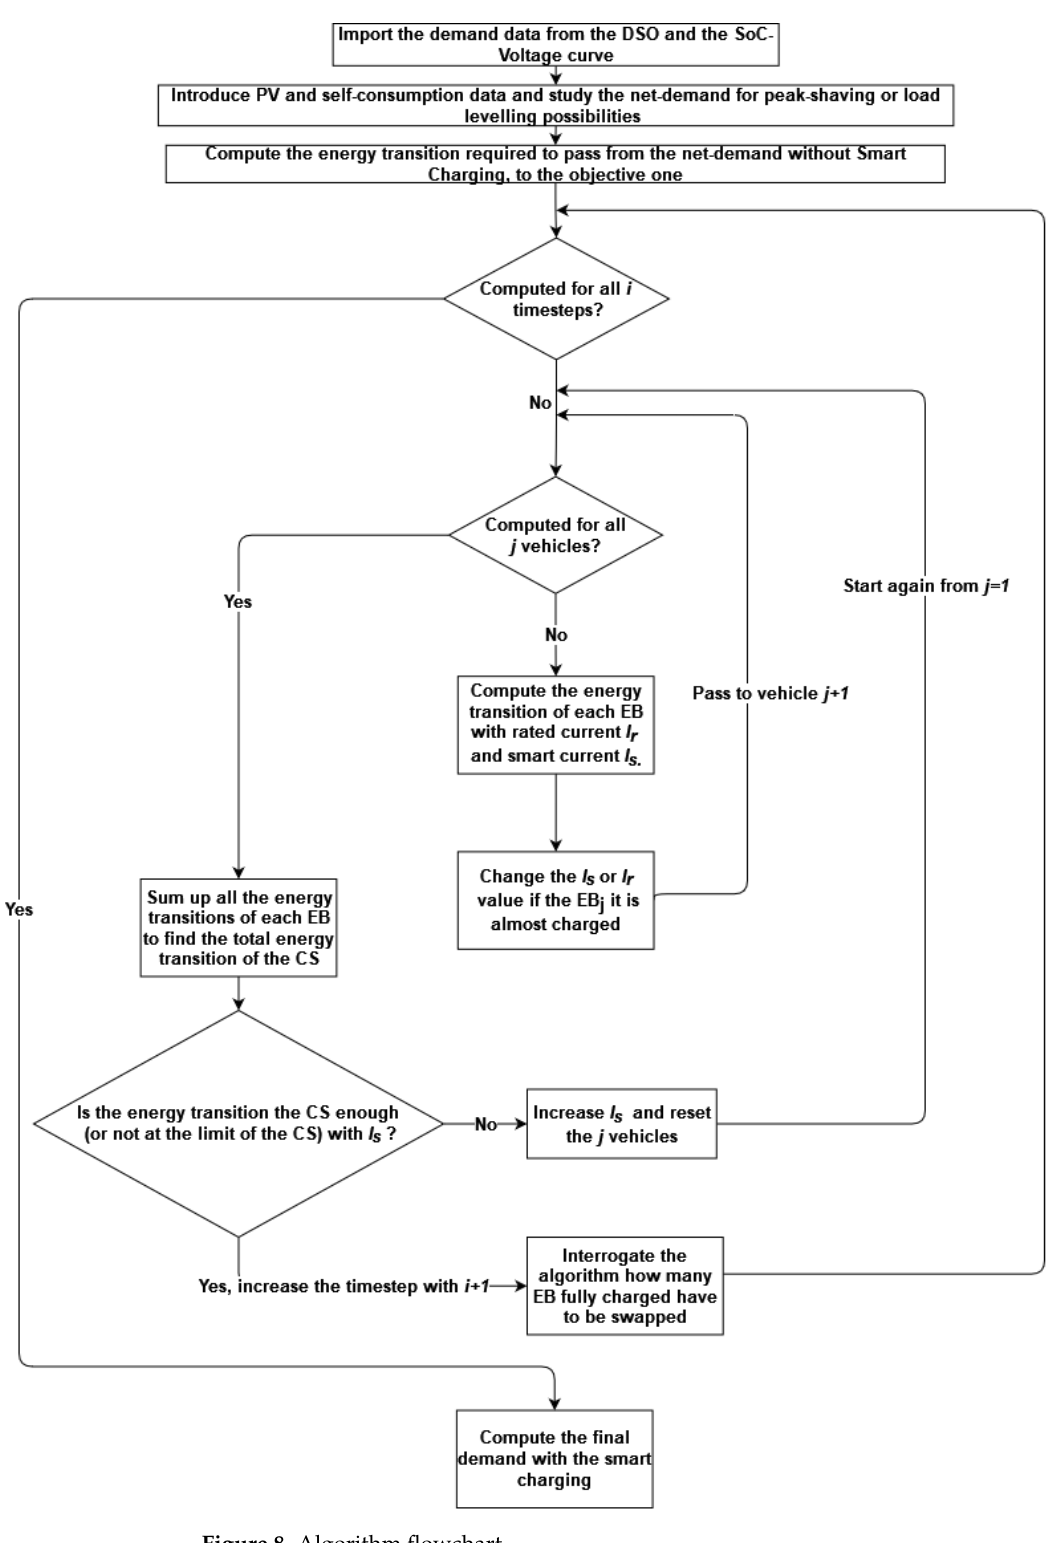
Figure 8. Algorithm